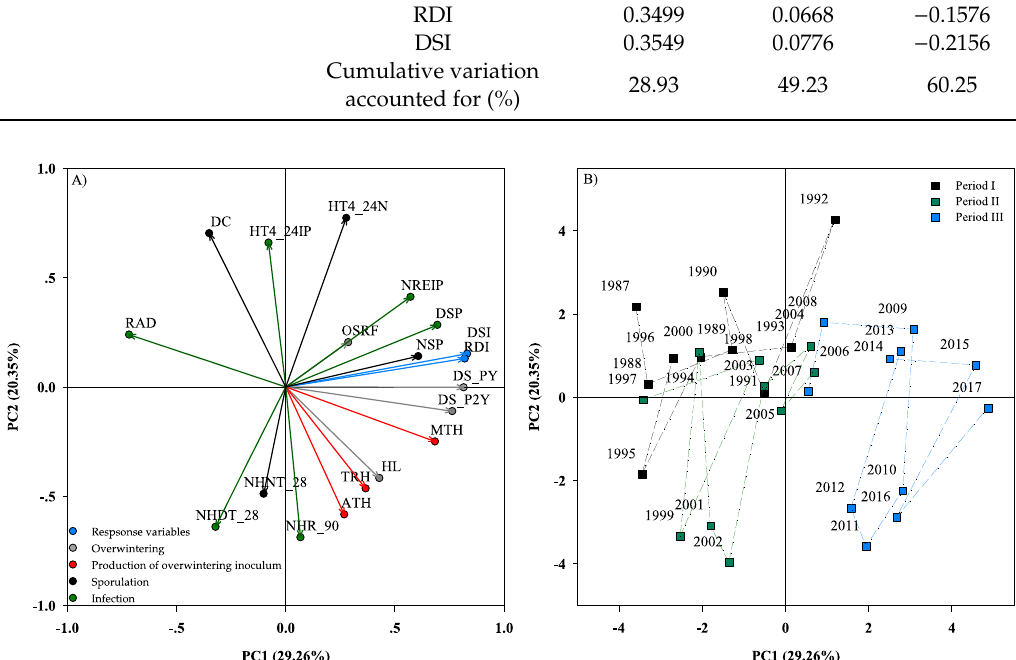
Figure 4. Principal component analysis (PCA) biplots obtained by using the first two principal components ( A ) in the variable space and ( B ) in the year space, where consecutive years are linked to allow following the temporal walk.